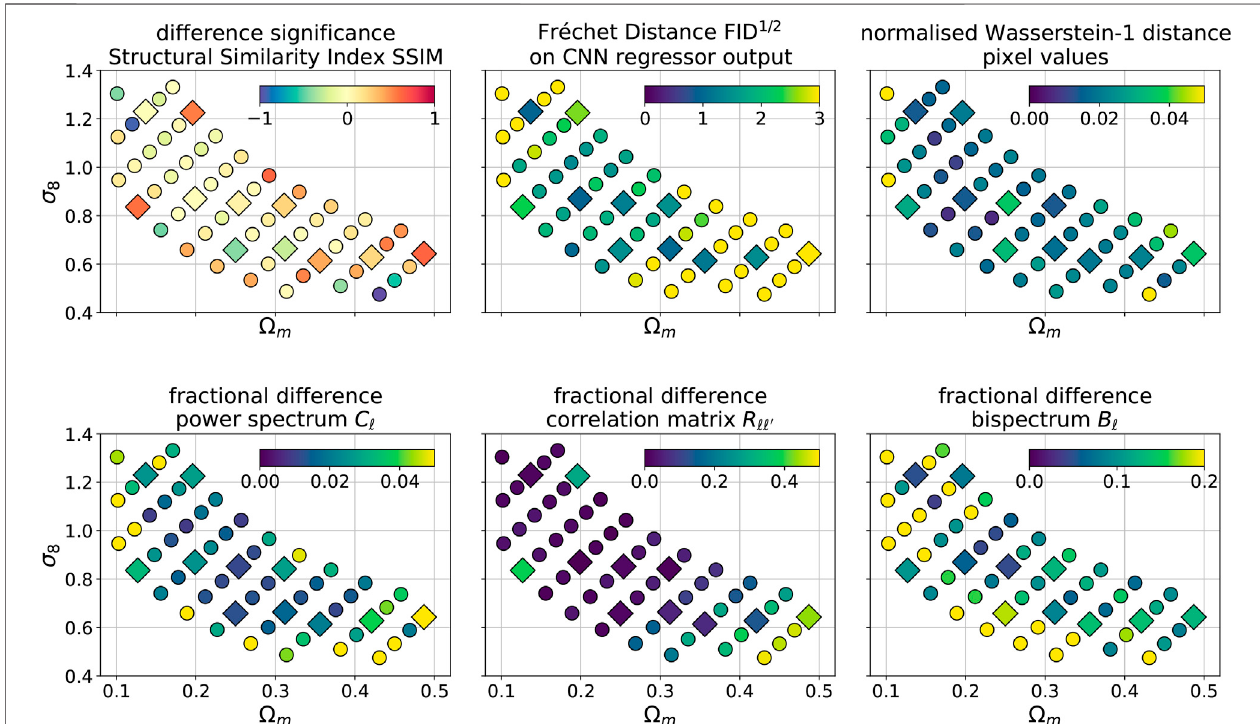
FIGURE10| DifferencesbetweensummarystatisticsoftheoriginalN-bodyandtheGAN-generatedimages.Theleftpanelshowsthesigni fi canceofthedifference inMulti-ScaleStructuralSimilarityIndex(MS-SSIM),de fi nedin Eq.4 .TheuppermiddlepanelpresentstheFréchetDistance,computedusingaregressorCNNand Eq.5 (see Section4 ).TheupperrightpanelshowsthenormalizedWasserstein-1distanceinthepixelvaluedistributions(see Section4 ).Thelowerleftpanelshowsthemean absolute fractional difference of the power spectra C ℓ . The lower middle panel shows the fractional difference in the Frobenius norms of correlation matrices, de fi ned in Eq. 3 . The lower right panel present the mean absolute fractional difference of the bispectrum B ℓ . The circles and squares indicates parameters from the training and the test sets.